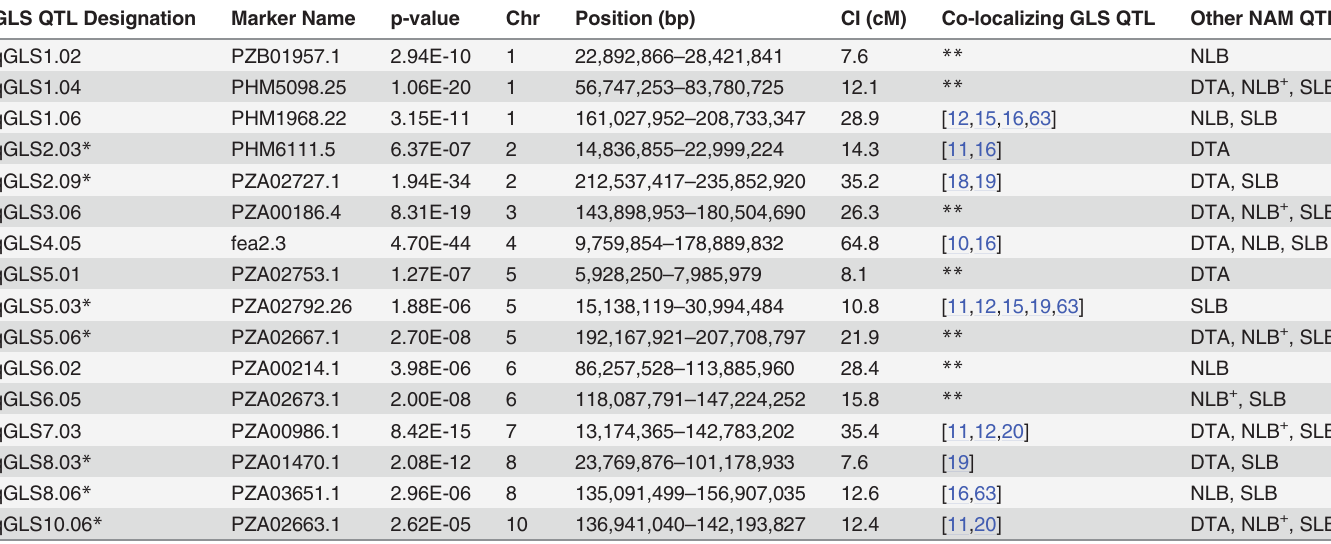
Table 2. Summary of resistance to gray leaf spot (GLS) in the nested association mapping population. GLS QTL